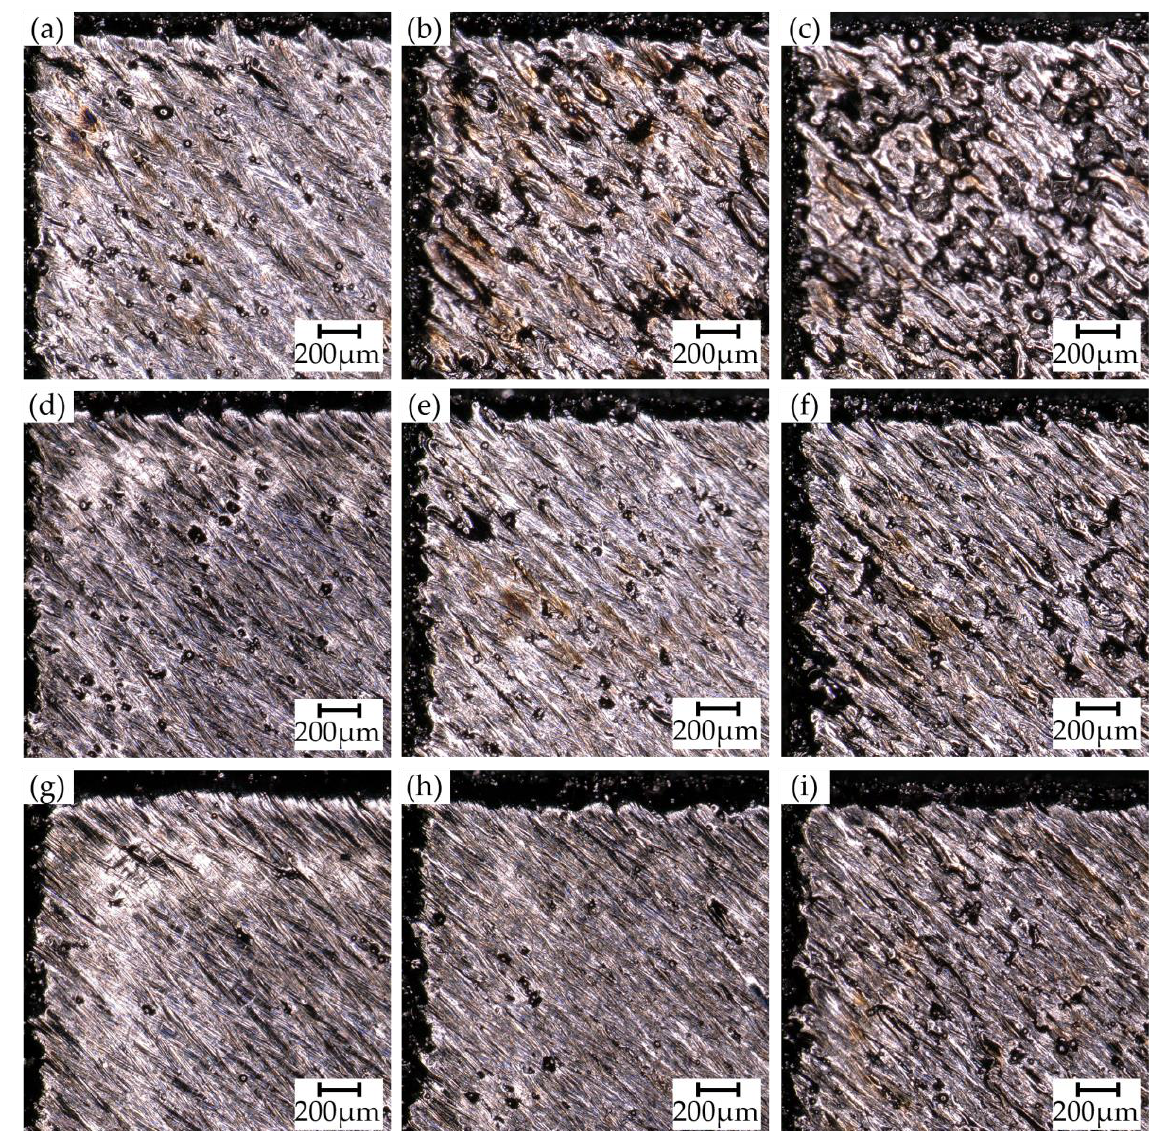
Figure 4. Upper surface morphology under different parameters: ( a ) 100 W, 600 mm/s; ( b ) 100 W, 1000 mm/s; ( c ) 100 W, 1400 mm/s; ( d ) 140 W, 600 mm/s; ( e ) 140 W, 1000 mm/s; ( f ) 140 W, 1400 mm/s; ( g ) 180 W, 600 mm/s; ( h ) 180 W, 1000 mm/s; ( i ) 180 W, 1400 mm/s.